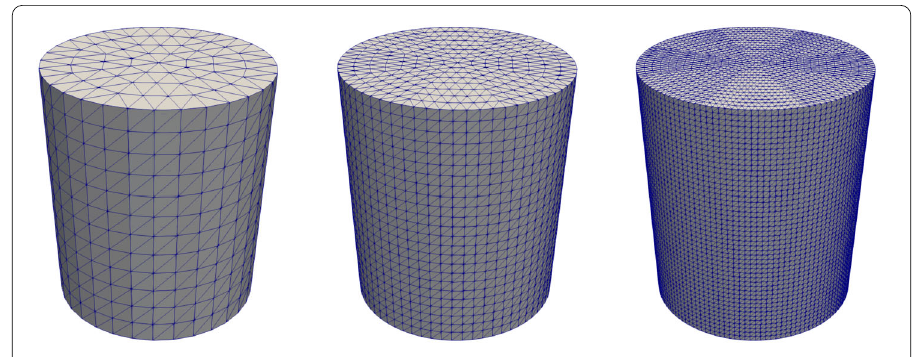
Figure 2 Triangulations of the ladle, meshes for levels 2, 3, and 4